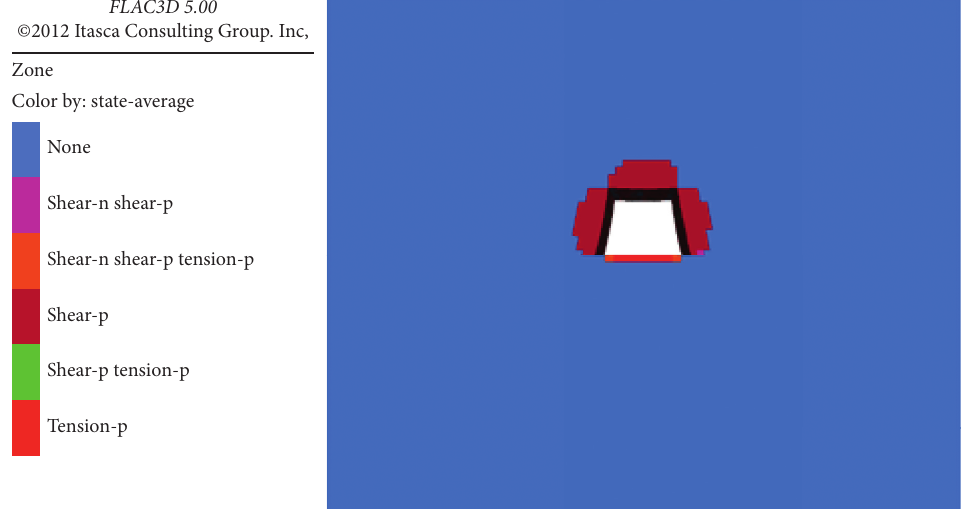
Figure 13: Distribution of plastic zone in the surrounding rock of the new support